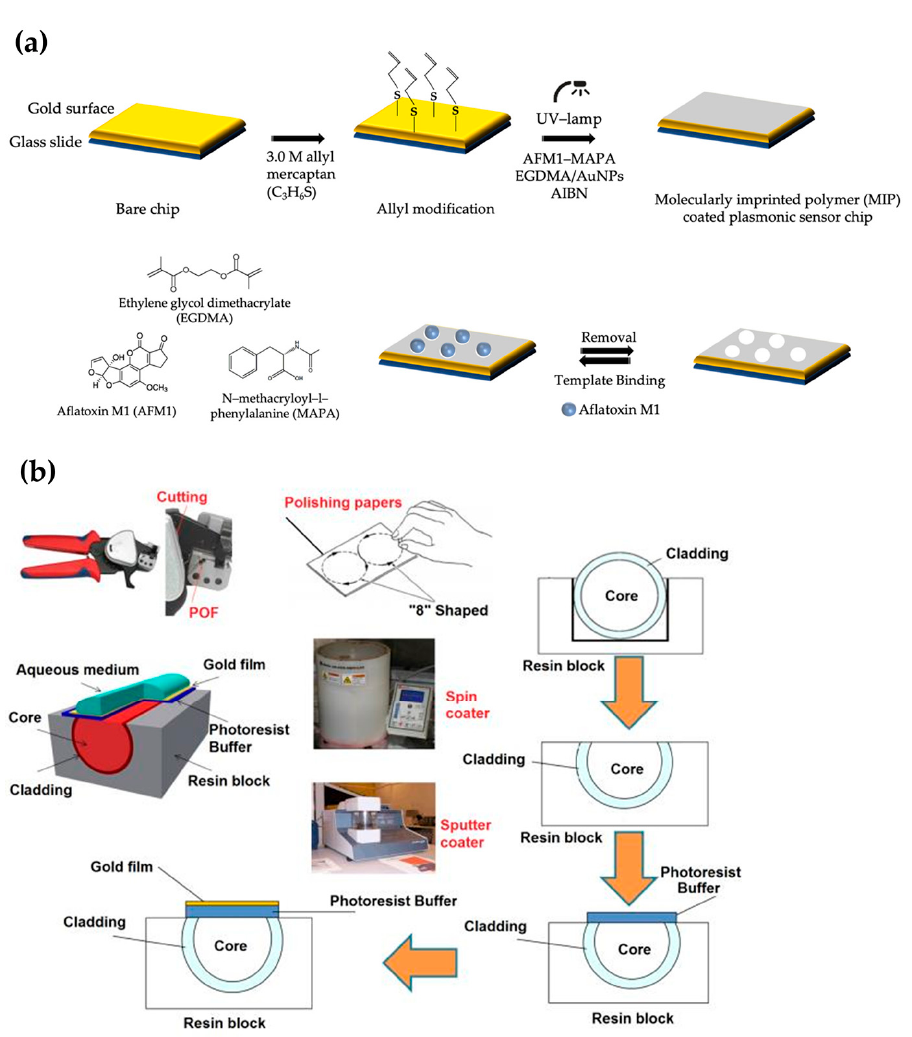
Figure 4. ( a ) Preparation of an MIP-SPR sensor chip [30] and ( b ) preparation of a POF-SPR sensor platform [34]. Copyright 2022 Elsevier (Amsterdam, The Netherlands).